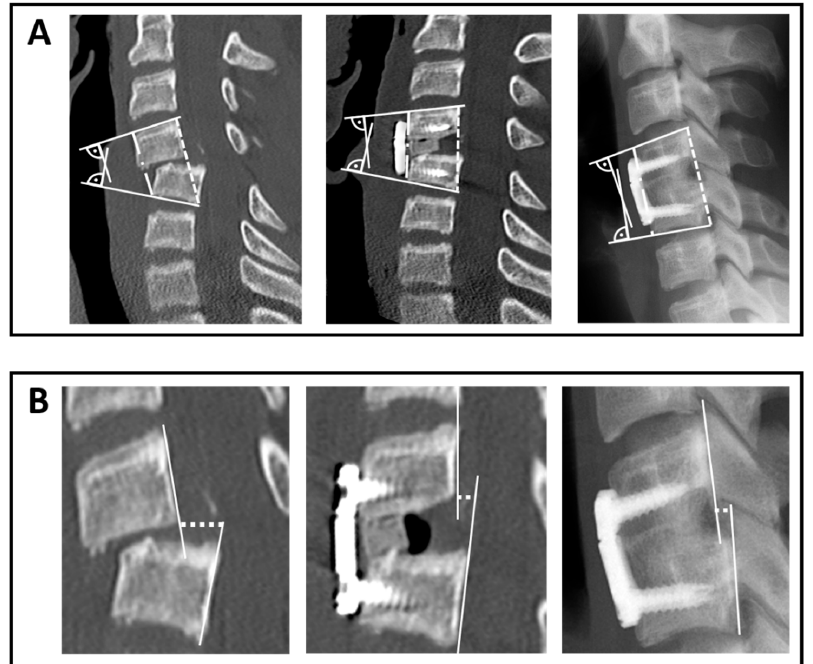
Figure 1. Example CT scan pre- and postoperative and lateral X-ray scan at follow-up. ( A ): Measurement of the mEA and the ventral and dorsal wall. The mEA (or bEA) was measured between the upper endplate of the superior vertebra and the inferior endplate of the inferior vertebra of the affected segment. The dotted lines indicate the measurement of the ventral and dorsal wall. ( B ): Measurement of the sagittal translation. The dotted lines mark the measurement of the sagittal translation.